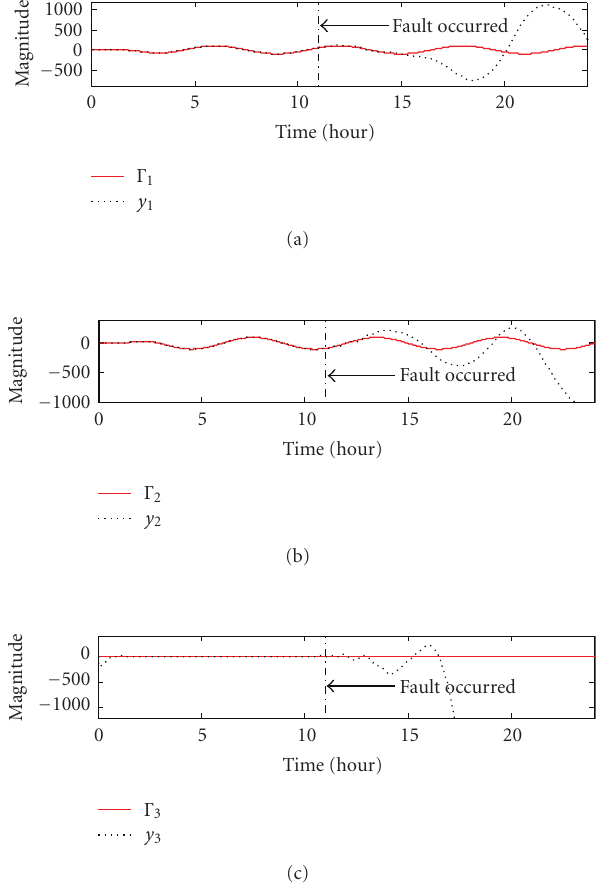
Figure 13: Output responses of Scenario 1 without fault-tolerant